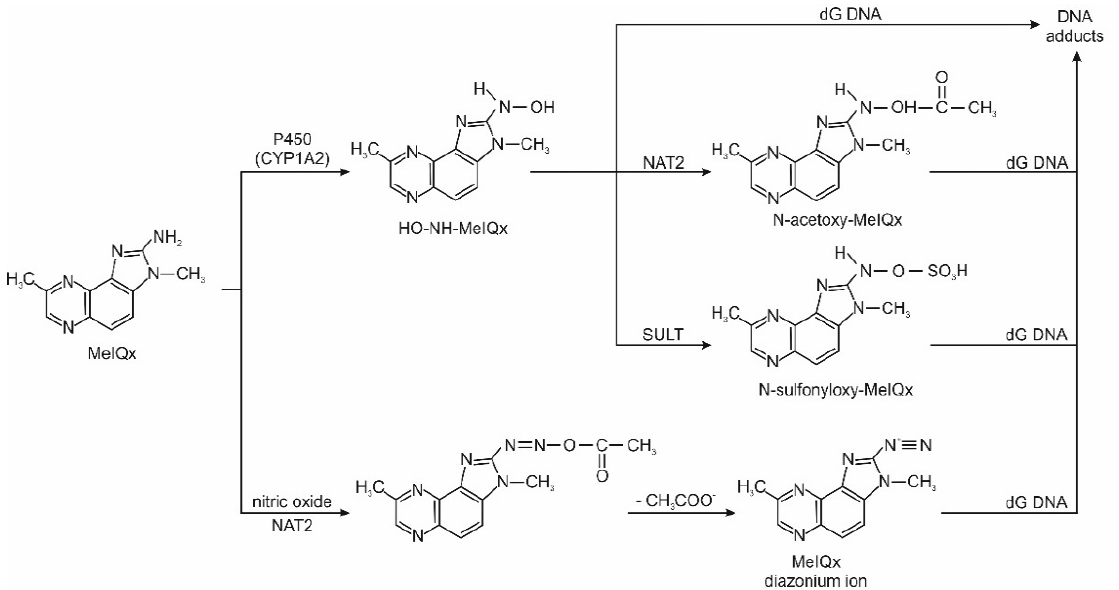
Figure 3. HAA metabolism pathway of MeIQx based on references [46,47]. Abbreviations: NAT2— N-acetyltransferases; SULT—sulfotransferases; dG—deoxyguanosine.